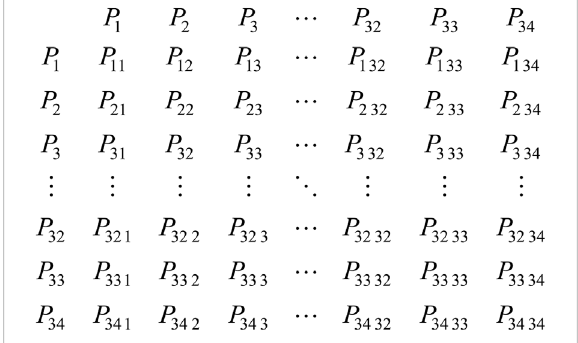
FIGURE 2 Schematic representation of spectral clustering similarity